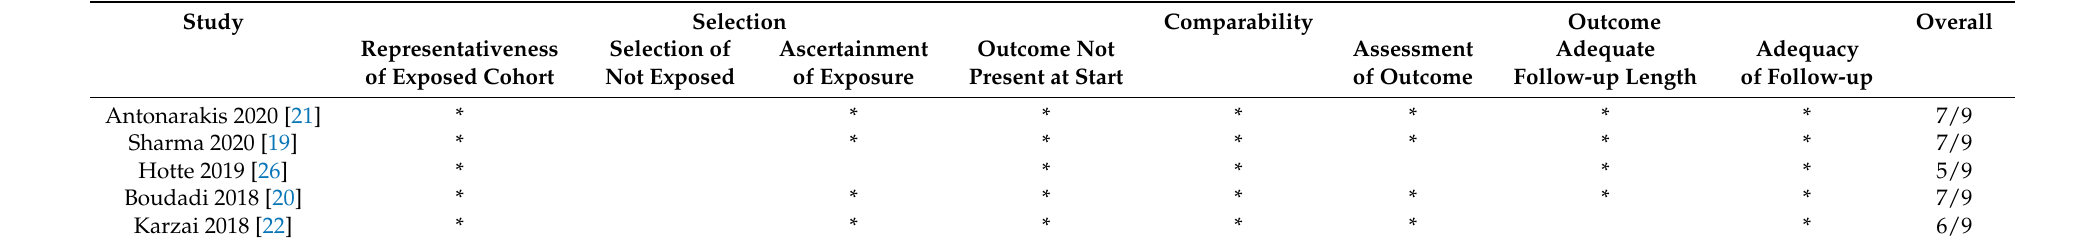
Table 2. Newcastle–Ottawa Scale for risk of bias assessment of the non-randomized trials (scores ≥ 7–9, 4–6, <4 are considered as low, intermediate, and high risk,